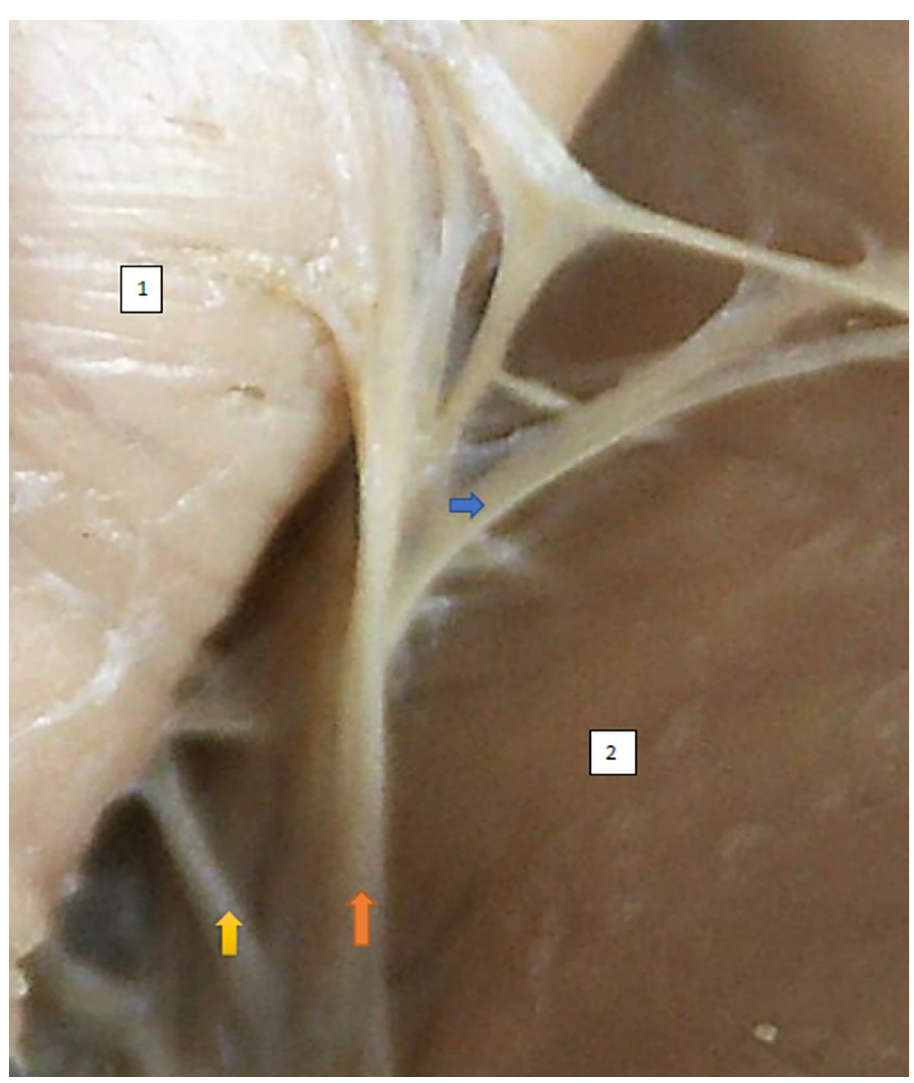
Fig 7. Superior gluteal nerve bushy type, vertical course, variform meshes of the net on the branch extending to gluteus medius morphological age 195–28–VII, v–tub 235,v–pl 337, mass 842, male sex, magnification 50 x, 1– gluteus medius muscle, 2– gluteus minimus muscle, red arrow–branch to gluteus medius muscle, yellow arrow– branch to gluteus minimus muscle, blue arrow–branch to tensor fasiae latae muscle.